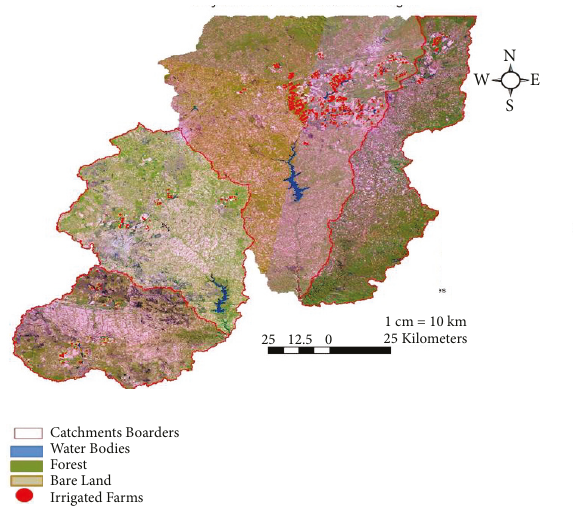
Figure 7: Classified landsat images from study area showing classified irrigated